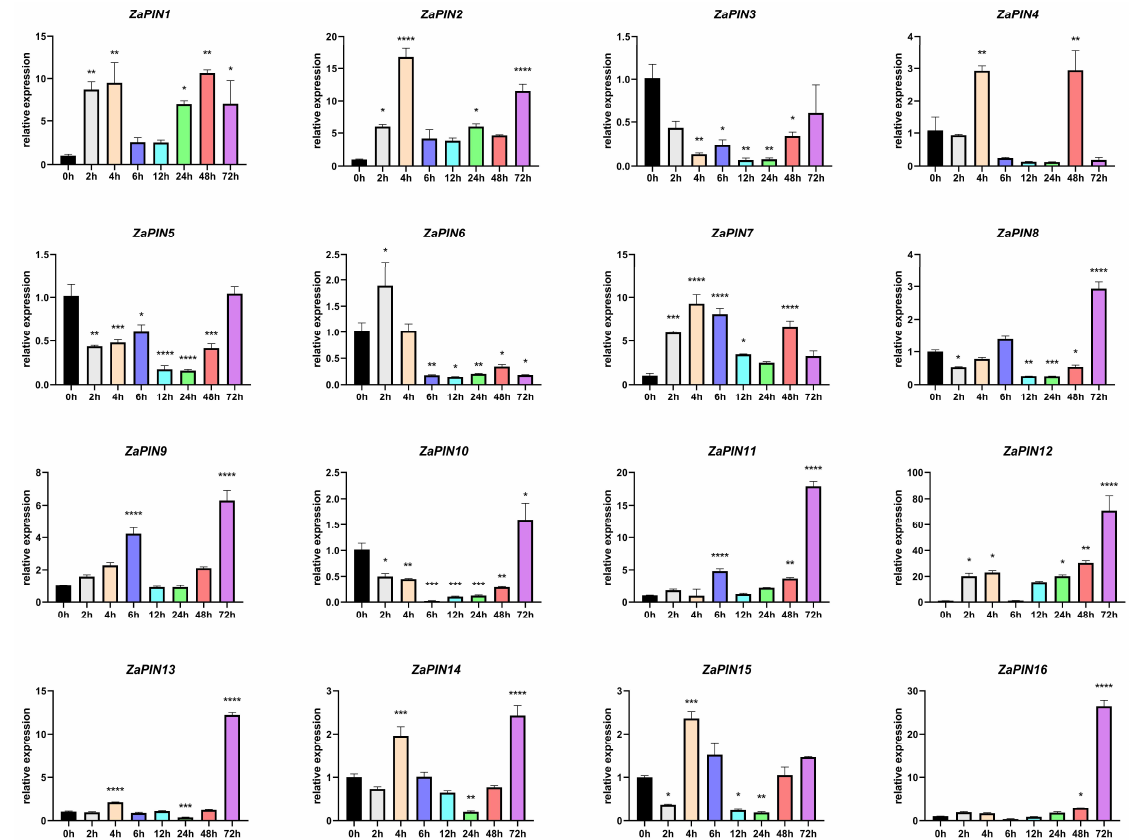
Figure 9. Relative transcript levels of ZaPINs under auxin (NAA) treatment. Values are mean ± standard deviation based on triplicate experiments. Each time point will be compared to the 0 h group and significance will be calculated using a t-test: * indicated p < 0.05, ** indicated p < 0.01, *** indicated p < 0.001, **** indicated p < 0.0001.